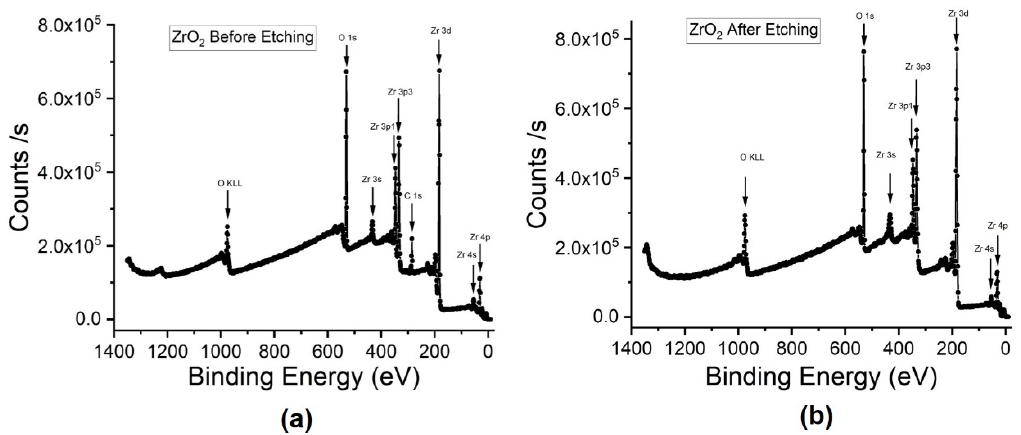
Figure 3. ( a ) XPS survey scan of the ZrO 2 thin film before etching; ( b ) XPS survey scan of the ZrO 2 thin film after etching.